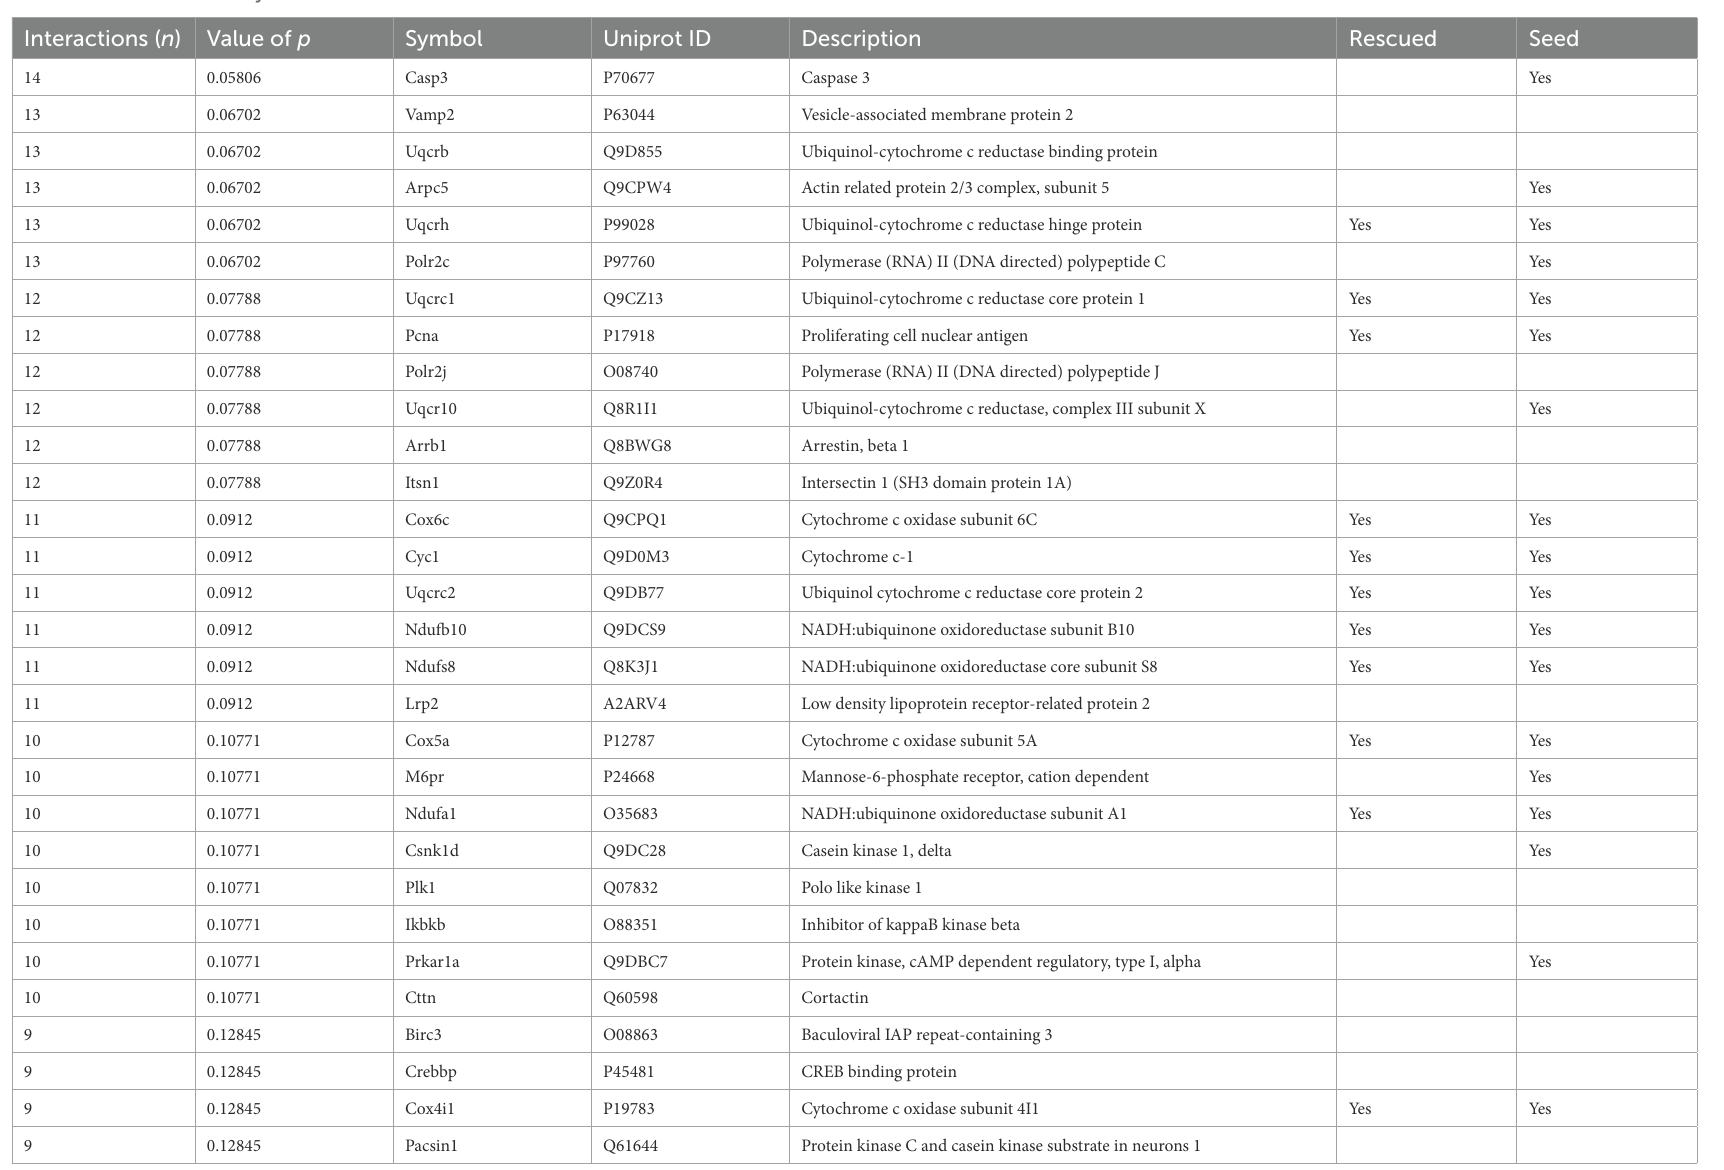
TABLE 2 Protein hubs in TG Dyrk1A cerebellum network. Interactions ( n